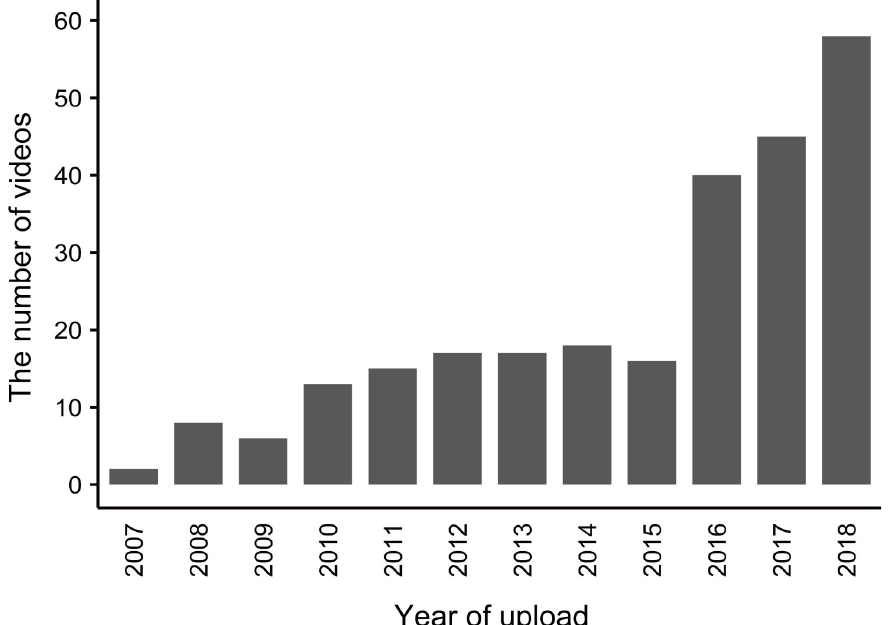
Fig 1. The number of YouTube videos related to mountain gorilla tourism that were uploaded in each year between 2007 and 2018. (3.5%) videos, while 62 (22.0%) videos were coded as “NA” and 210 (74.5%) videos were coded as “not used”. The risk of disease transmission was explained in only eight (2.5%) vid- eos, while 29 (10.3%) videos were coded as “NA” and 246 (87.2%) videos were coded as “not